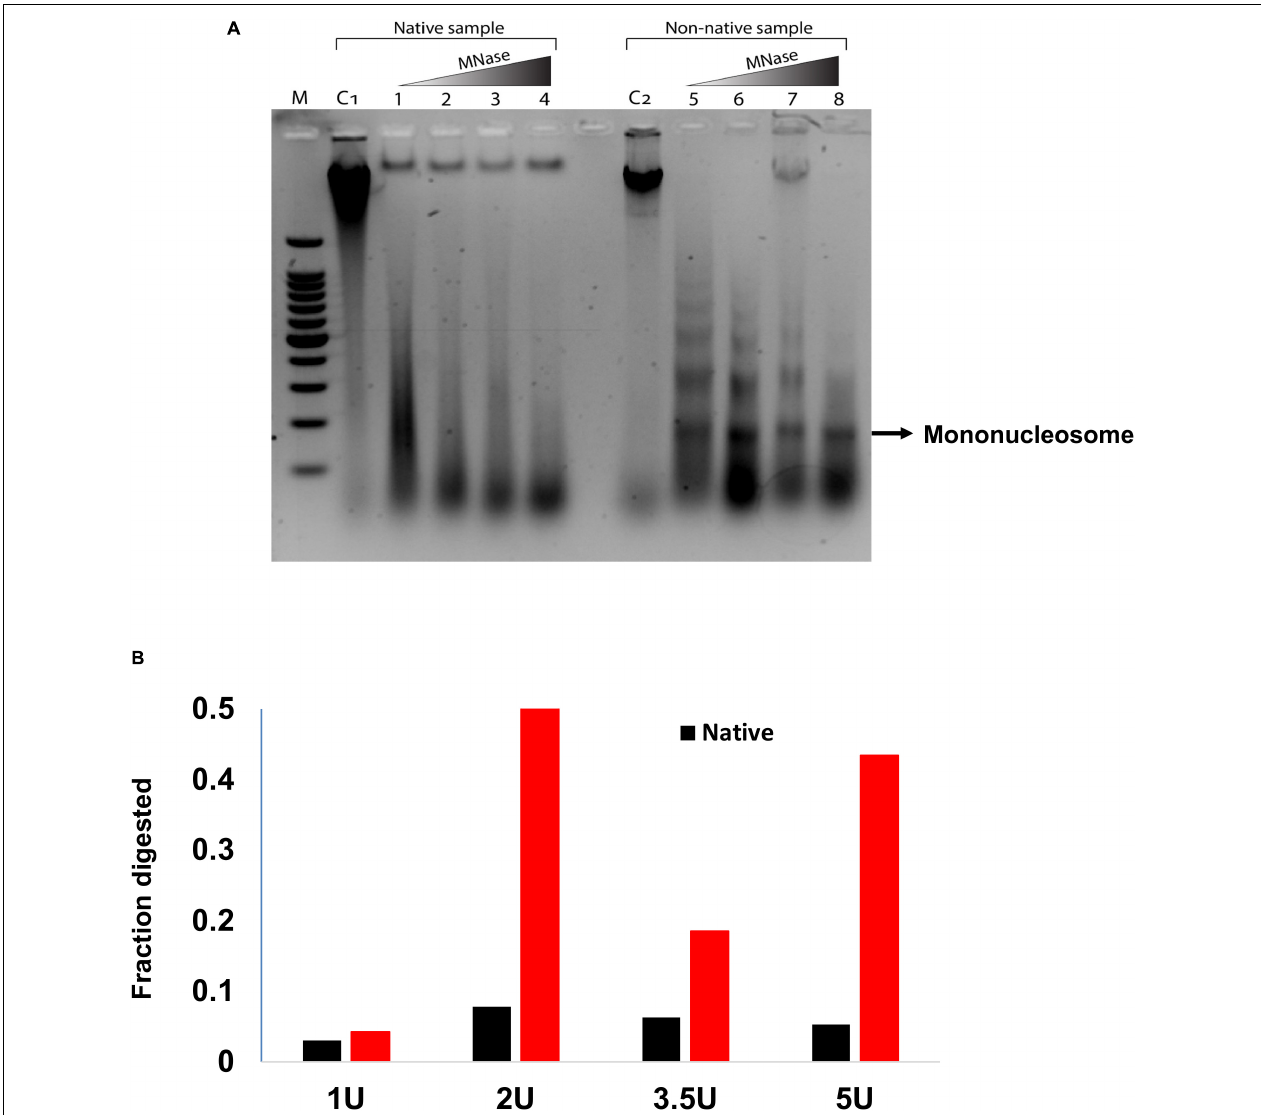
FIGURE 4 | MNase digestion assay in the native (North America) and non-native (Kashmir Himalaya) range plants. (A) The chromatin was isolated from plant samples of both native and non-native range Conyza canadensis and subjected to MNase digestion with different enzyme concentrations as mentioned in “Materials and Methods” section. (B) The bar graph represents the percentage of mononucleosomal fractions digested in the native and non-native range